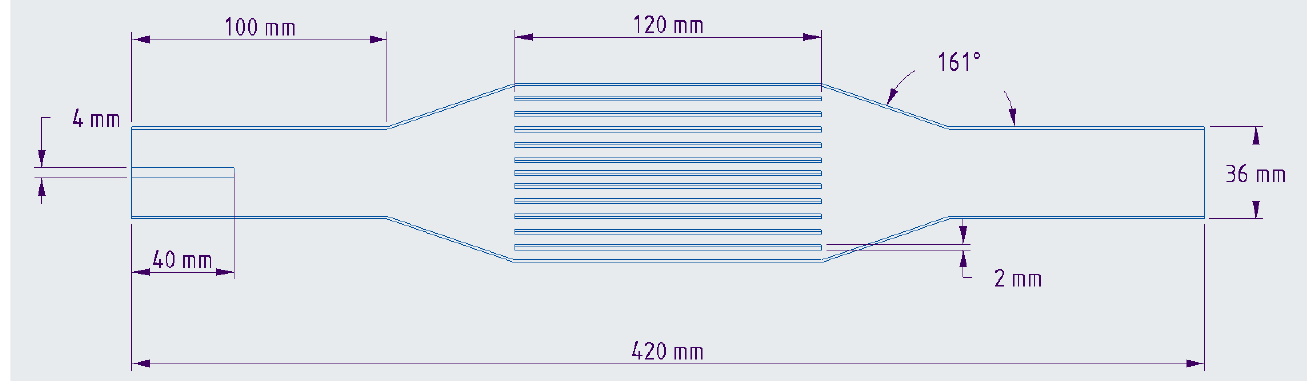
Figure 1. Computational domain of MHD pump-based cooling for traction inverter.